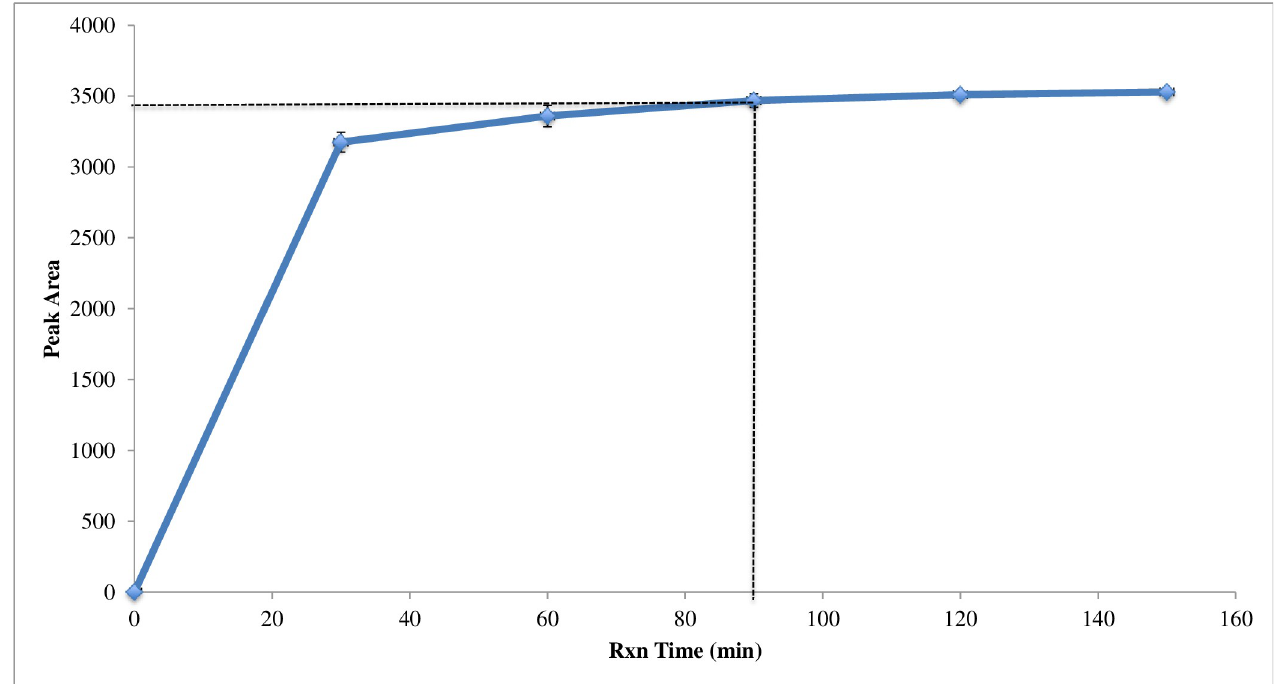
Fig 2. Peak area of PMP-Glucose as a function of derivatization reaction time. The peak area of PMP-Glucose remains constant after 90 minutes indicating that the reaction has reached completion.